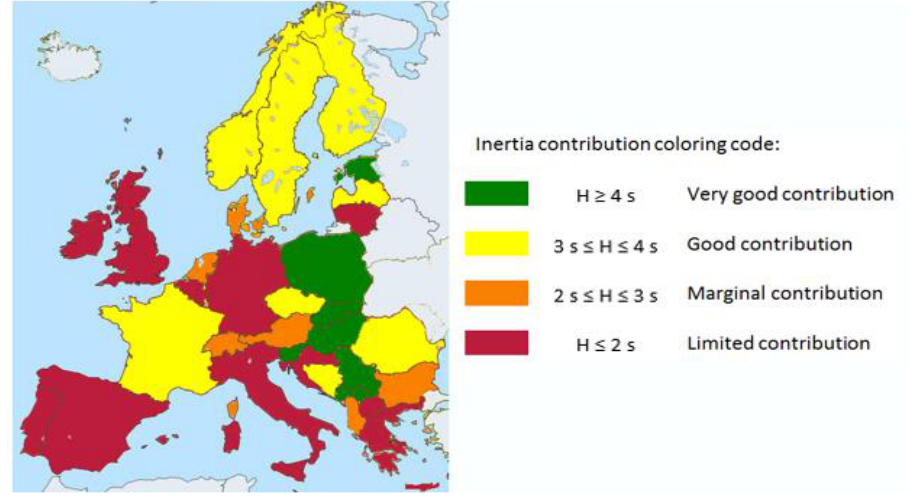
Figure 2. Indicating the contribution of each Transmission System Operator (TSO) to the total system inertia (European Network of Transmission System Operators for Electricity (ENTSO-E)—Ten Year Network Development Plan 2016).